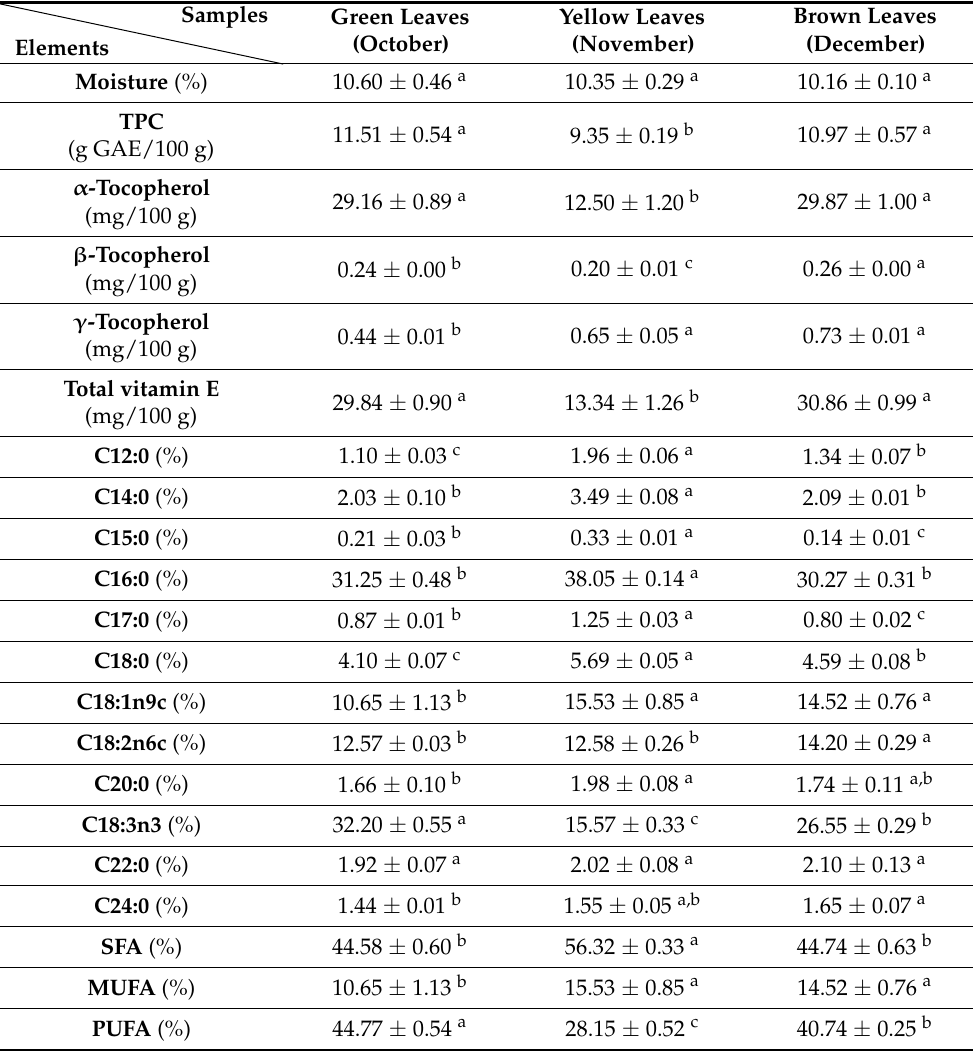
Table 2. Organic analysis of leaf samples of Cydonia oblonga . Results expressed as mean ± stan- dard deviation ( n = 3). Different letters denote significant differences ( p > 0.05).